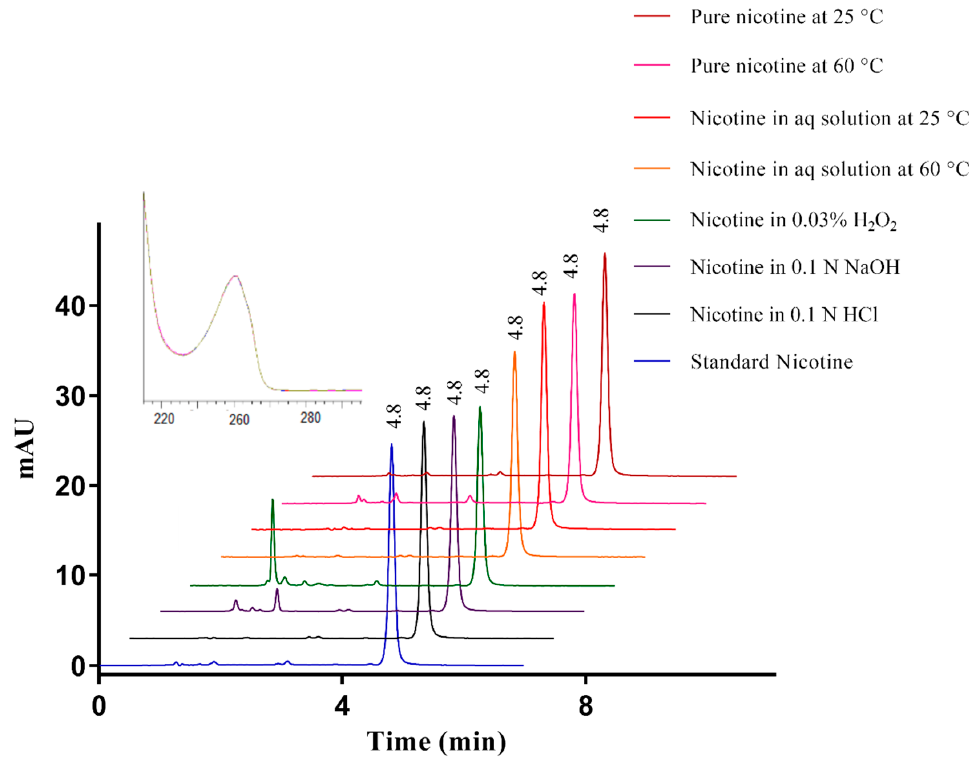
Figure 1. Chromatograms of nicotine standard and in selected stress conditions, starting